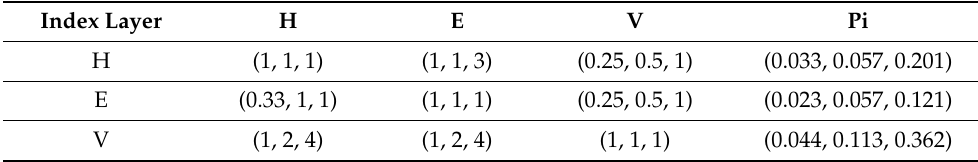
Table 4. Index layer weights determined by TFN-AHP.